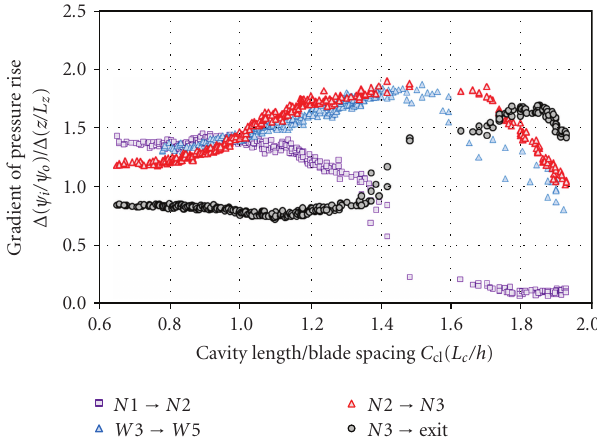
Figure 9: Comparison of the gradient of pressure rise between liquid nitrogen and water.